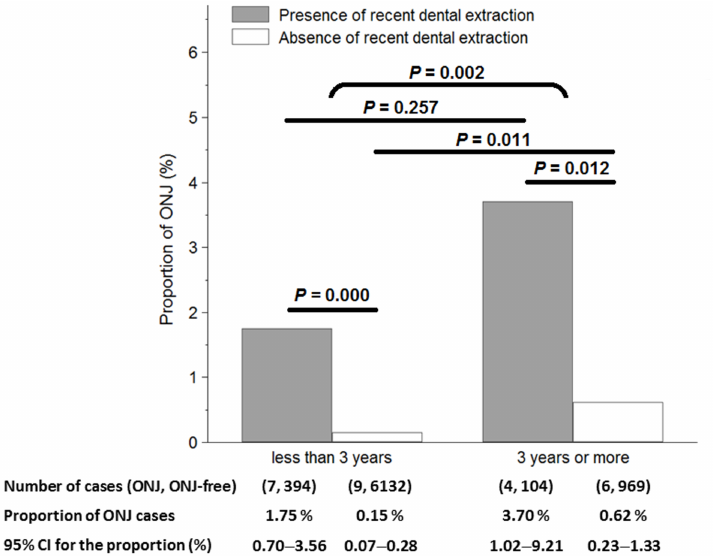
Fig 3. Tooth extraction increases the risk of ONJ independent of the duration of alendronate therapy. The overall prevalence of ONJ in osteoporotic subjects taking oral alendronate is estimated at 0.34% (26/7625) which rises to 2.16% (11/509) after recent tooth extraction. The difference in the proportions of ONJ between subjects with and without recent tooth extraction is computed using the Fisher’s exact method. Tooth extraction is significantly associated with increased risk for ONJ among osteoporotic patients taking alendronate for 3 years or more ( P = 0.012) and in those with less than 3 years of use ( P < 0.001), independent of drug duration. In addition, there is a greater proportion of ONJ among patients with BP duration of 3 years or more versus less than 3 years of use (0.92% versus 0.24%, P = 0.002), supporting the influence of BP duration on ONJ occurrence.